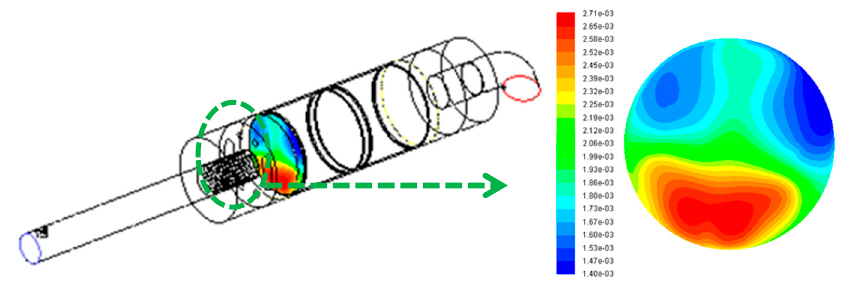
Figure 10. NH 3 distribution of the optimization nozzle (UI = 0.92, Operation Points 1).